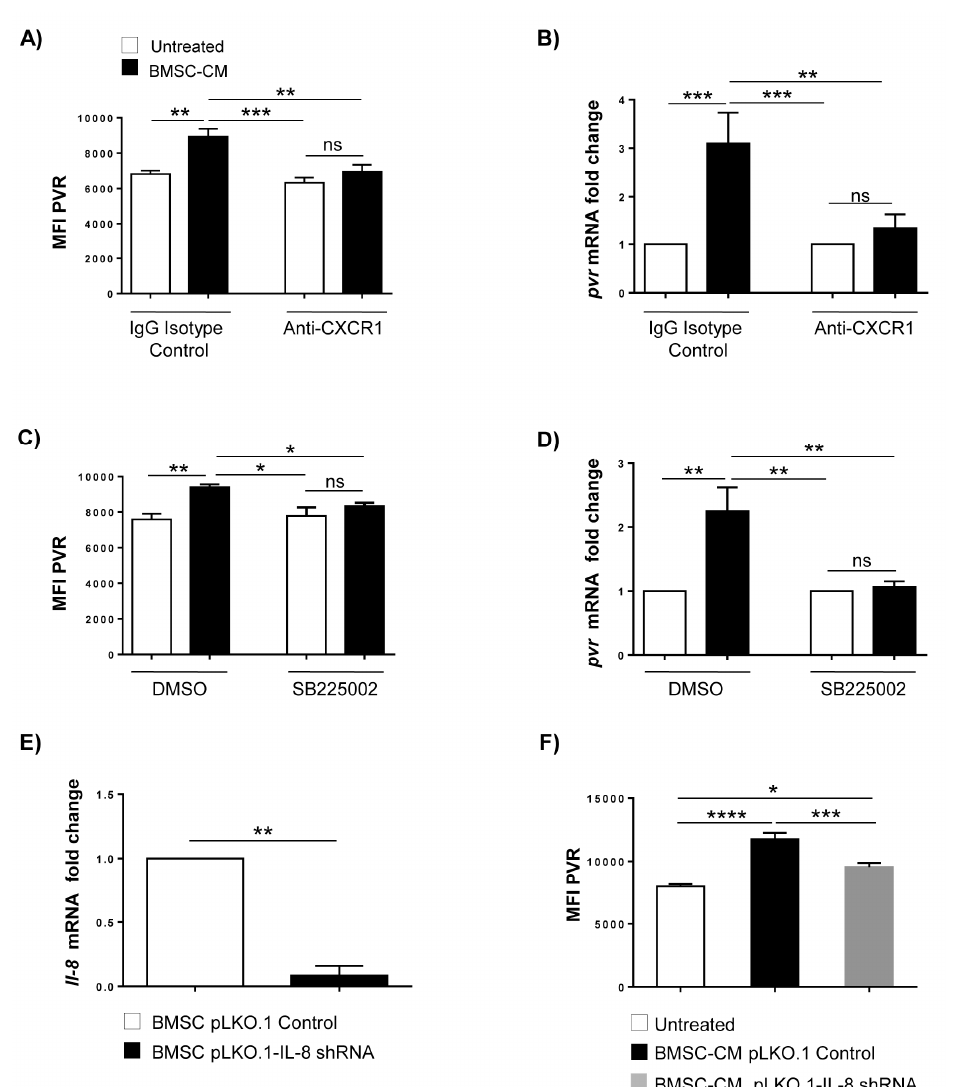
Figure 6. Blockade of CXCR1/2 receptors prevents PVR upregulation by BMSC ‐ CM. PVR surface expression was analysed by flow cytometry. SKO ‐ 007(J3) cells were pre ‐ treated with anti ‐ CXCR1 or IgG control ( A ) or with SB225002 or vehicle control (DMSO) ( C ), and stimulated by BMSC ‐ CM. Real Time PCR analysis of total PVR mRNA obtained from SKO ‐ 007(J3) cells after 48h stimulation with BMSC-CM and pretreatment with anti-CXCR1 blocking mAb ( B ) or SB225002 ( D ) as described